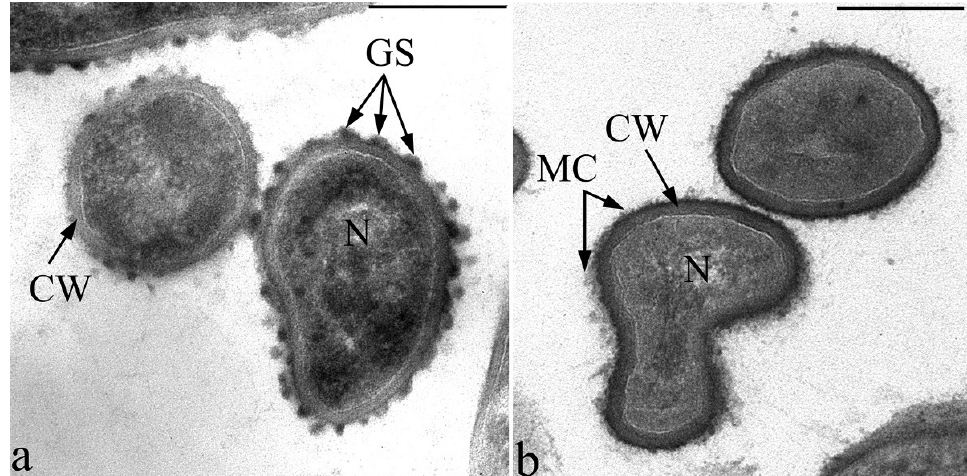
Figure 1. Transmission electron microscopy. Ultrathin sections of the strain F2E cells ( a ) and cells of the most phylogenetically close type strain of M. lacticum VKM Ac-1145 ( b ), fixed in the presence of ruthenium red. Electron-dense globular structures (GS) on the surface of the cell wall of strain F2E ( a ) are indicated. Designations: GS—globular structure; CW—cell wall, MC—microcapsule, N—nucleoid. Bar—200 nm.